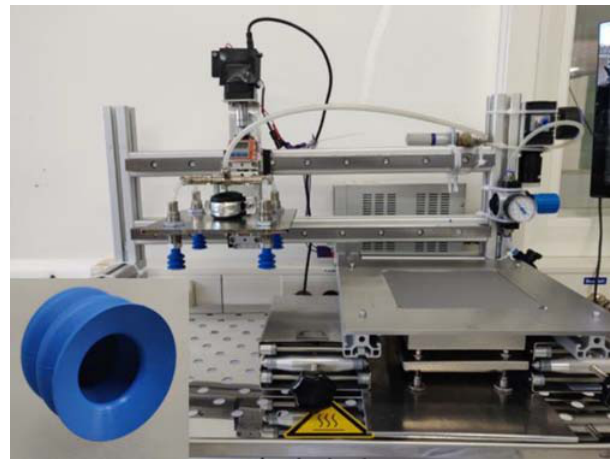
Fig. 2. Picture of tool used to grasp the wafers with magni fi ed picture of one out of four suction cups used